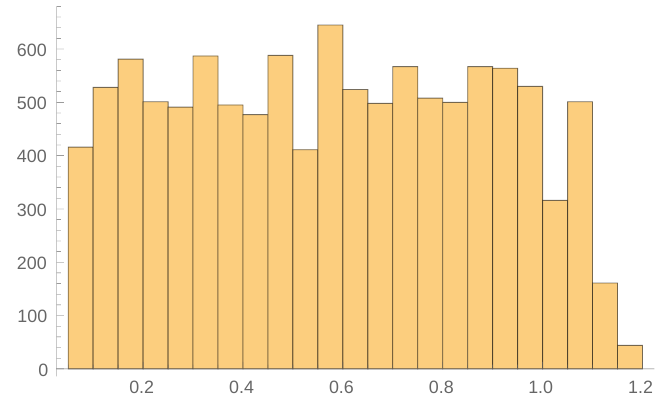
Figure 2 . Distribution of g s for L =